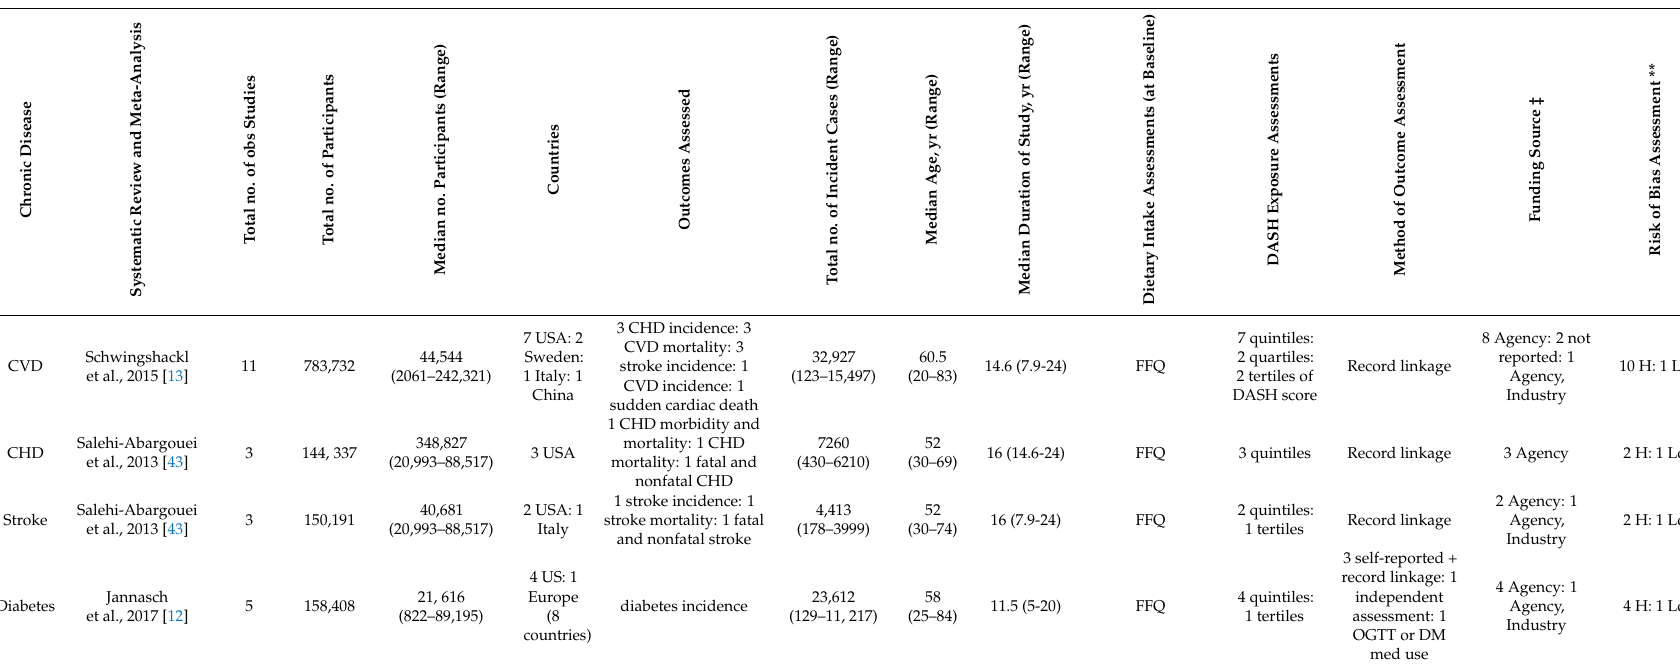
Table 1. Summary of characteristics of included studies in most recent systematic reviews and meta-analyses of prospective cohort studies assessing the effect of the DASH dietary pattern on chronic